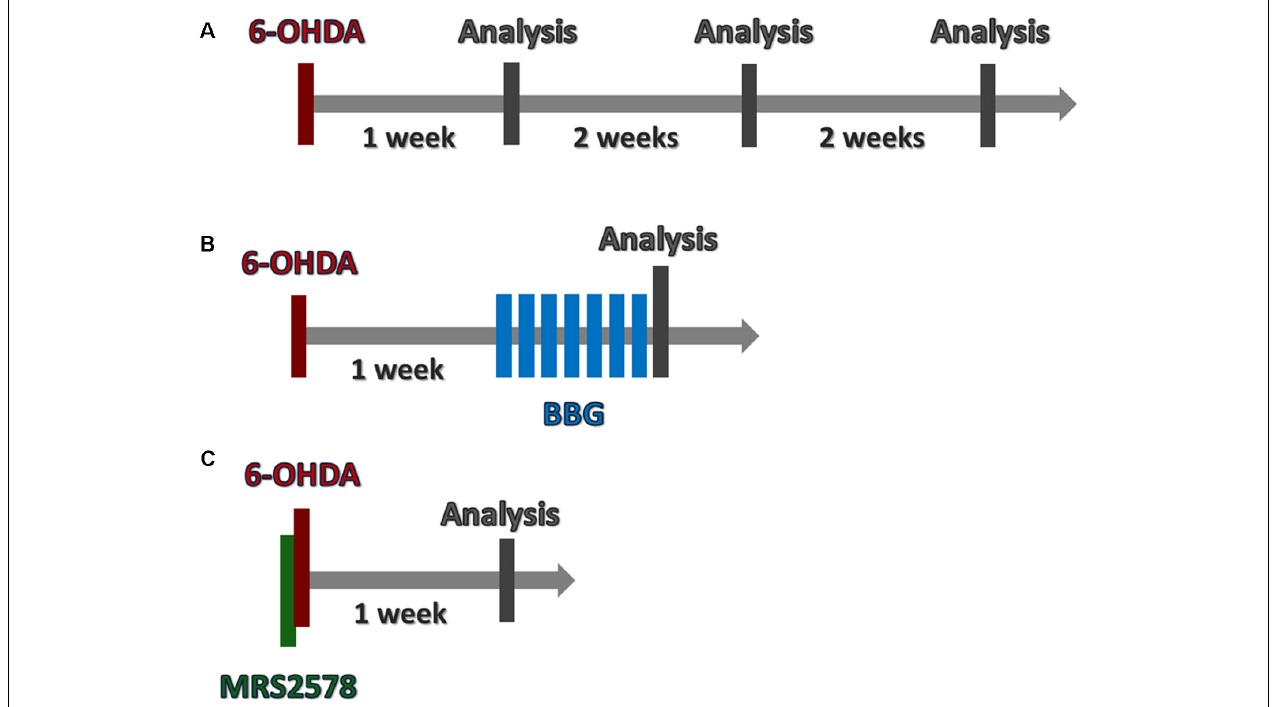
FIGURE 1 | Timeline of in vivo procedures. (A) To analyze 6-hydroxydopamine (6-OHDA) lesion progression, animals were submitted to 6-OHDA injection. Brains were collected following 1, 3 or 5 weeks. (B) One week after 6-OHDA injection, animals were treated daily with Brilliant Blue G (BBG), during 7 days. Twenty-four hours later, brains were collected. (C) MRS2578 was injected 10 min prior 6-OHDA injection. After 1 week, brains were collected. (A–C) Rotational test was performed before brain collection.